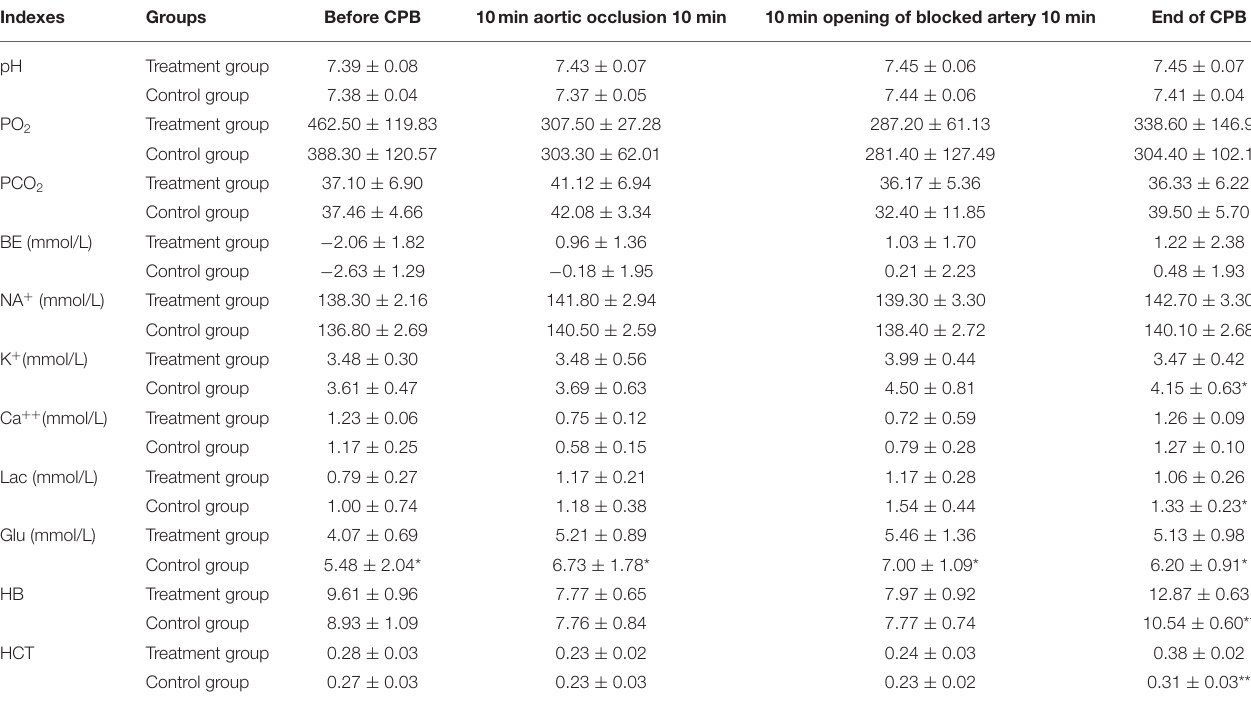
TABLE 3 | Test results of blood gas and electrolytes before and after CPB (x ± s, n = 15). Indexes